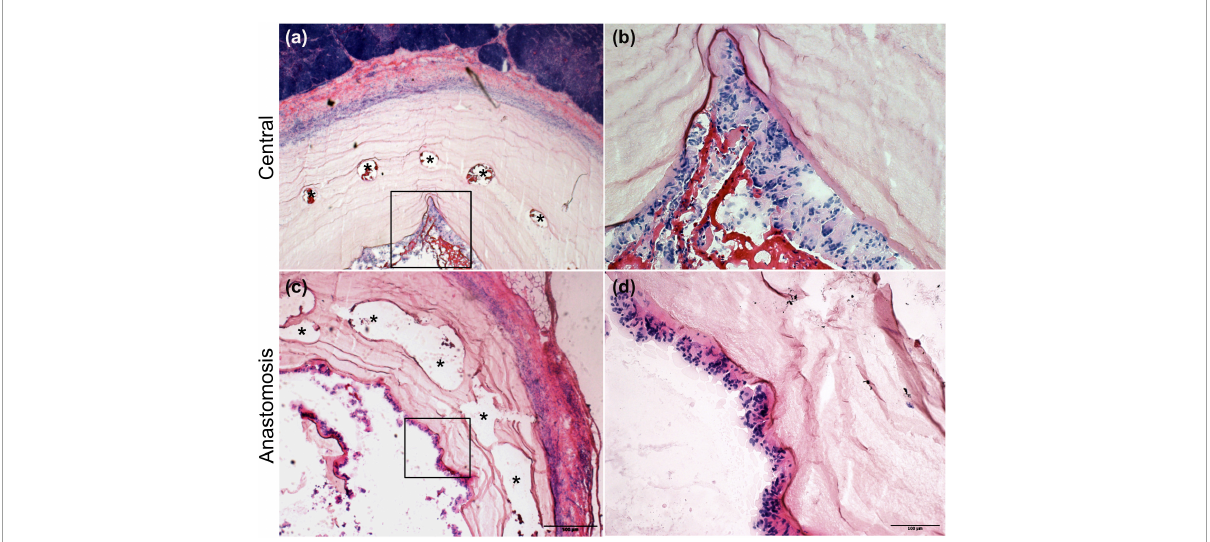
FIGURE4 H&E staining of the explanted grafts 4 weeks after implantation. The explanted Bacterial cellulose (BC)-vascular graft reveals a three-layered wall structure indicating remodeling by host cells. Representative images of the vascular grafts at the central part (a,b) and at the anastomosis site (c,d) at high 20 × (b,d) and low 4 × (a,c) magnifications. *indicates the empty holes left from the embedded mesh, which were removed during the histological process.